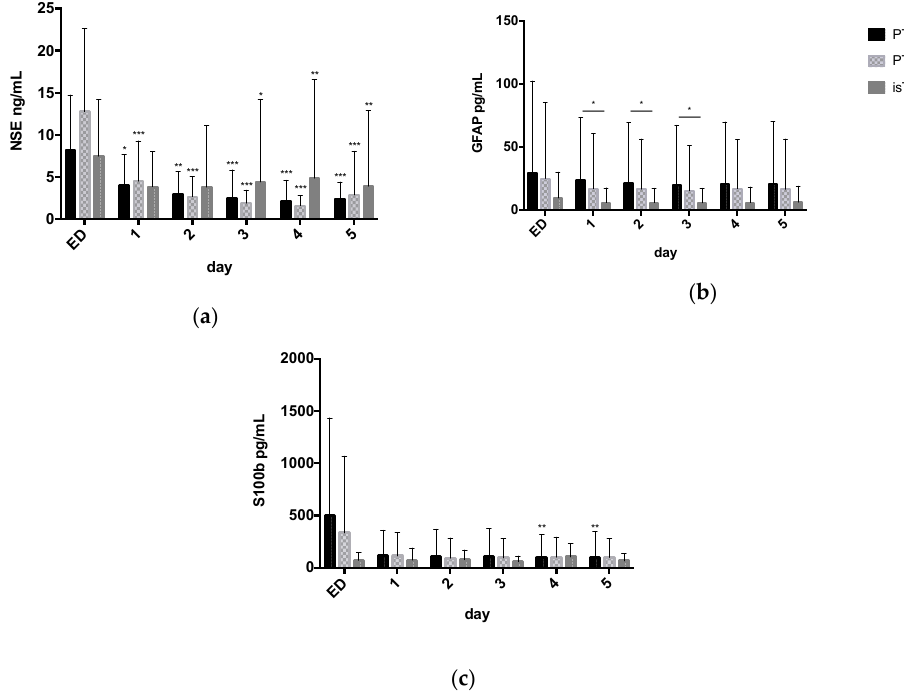
Figure 1. Neuronal serum marker levels (mean ± Standard Deviation) over the time course from admission to Emergency Department (ED) through to hospital day 5 stratified by injury pattern. * p < 0.05, ** p < 0.01, *** p < 0.001. ( a ) Neuron-specific enolase 2 (NSE) ( b ); glial fibrillary acidic protein (GFAP); ( c ) calcium-binding Protein B (S100b).